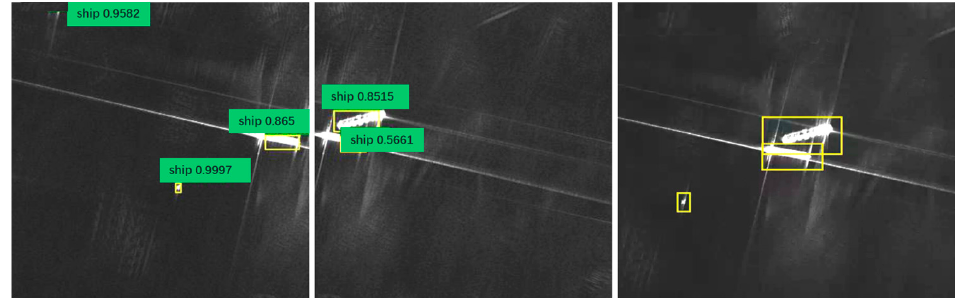
Figure 10. Sliding window chunking method effect schematic.